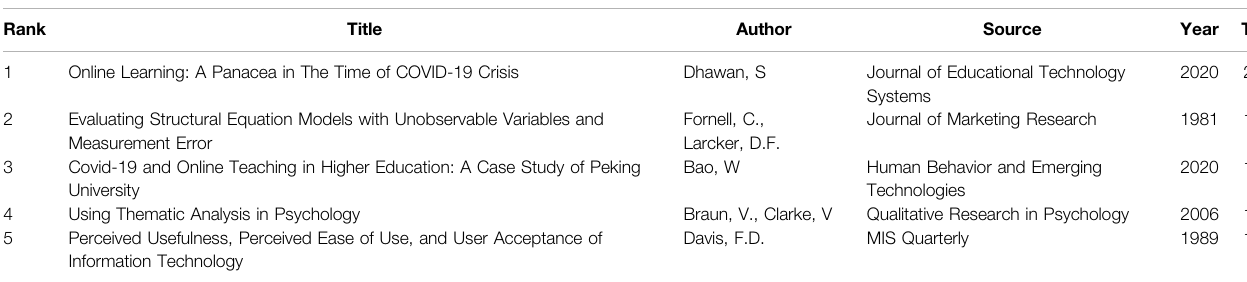
TABLE 5 | Top 5 cited references in E-learning and